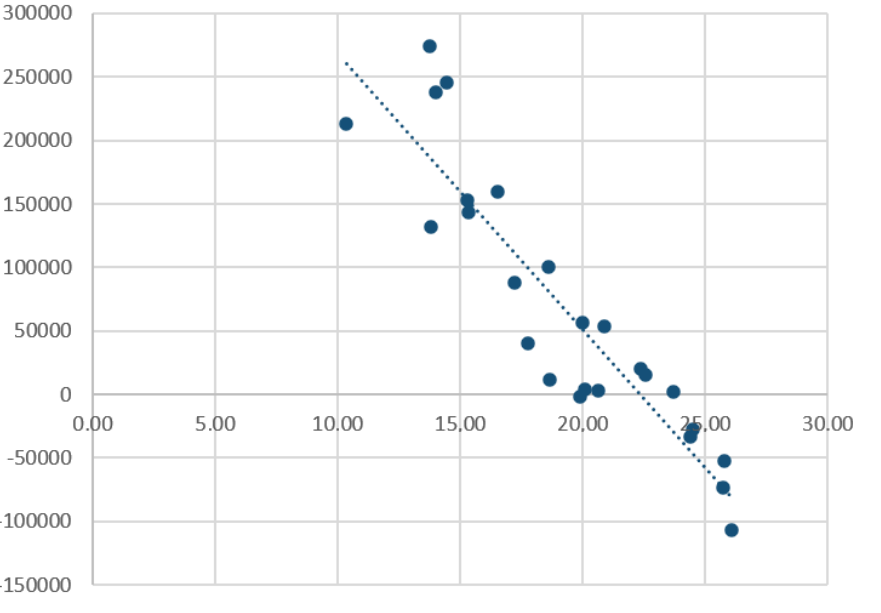
Figure 2. Linear correspondence between unemployment rate and net legal migration